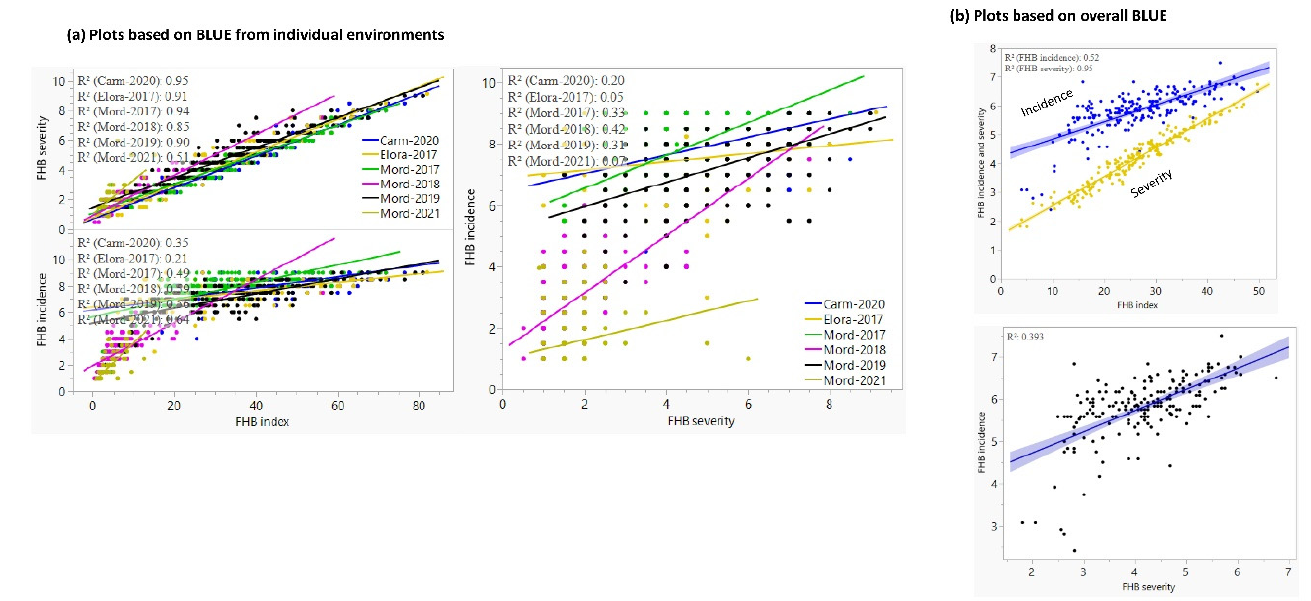
Figure 3. Regression plots of Fusarium head blight (FHB) incidence, severity, and index based on ( a ) individual environments, and ( b ) all six environments. The plots showed low R 2 between incidence and severity (0.05–0.42), low to moderate R 2 between incidence and index (0.21–0.64), and high to very high R 2 between severity and index (0.51–0.95). The environments are named using the site (Elora, Mord for Morden, and Carm for Carman) and the year of the experiment. Note that FHB incidence showed a lower R 2 value with FHB severity and index due to its greater environmental variances summarized in Table S3 and Figure